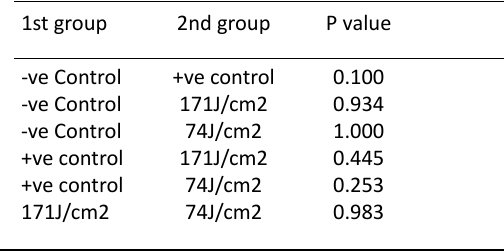
Table 14. Head circumferences comparison in day six between every pairs